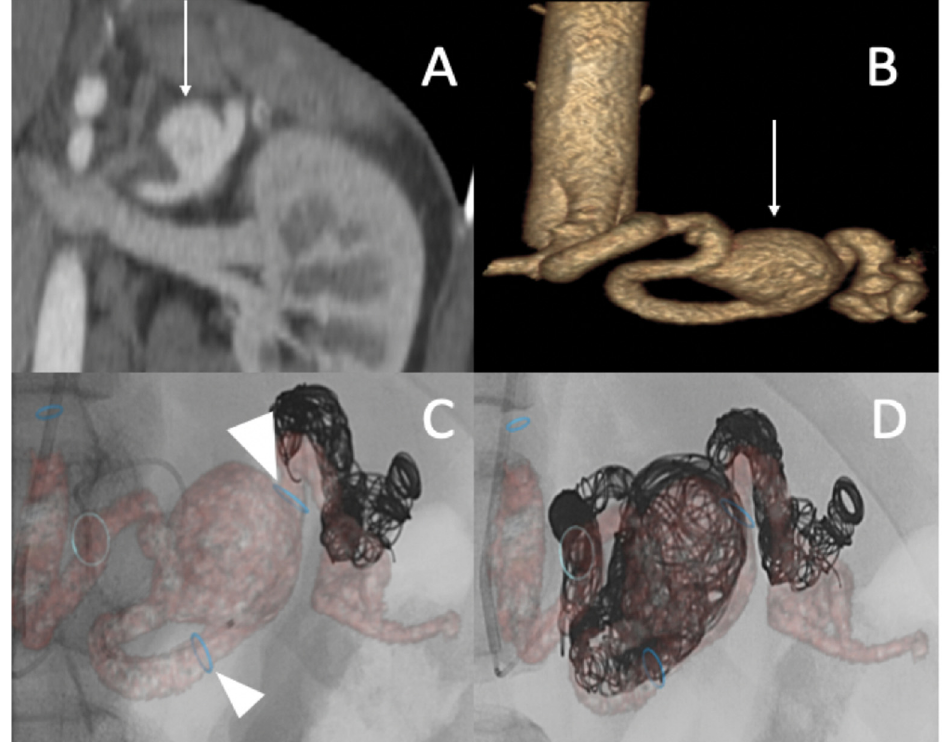
Figure 3. ( A , B ) Abdominal CT angiogram with 3D image and arteriography with image fusion ( C , D ) showing the aneurysm in the splenic artery (arrows). We marked the proximal and distal extremities of the neck of the aneurysm (head arrow), and then we started the embolization using multiple coils after, within, and before the aneurysm.